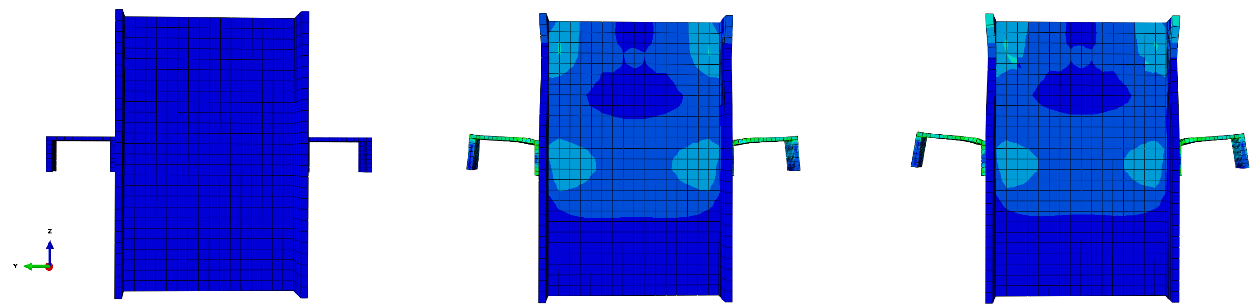
Figure 10. Step-by-step deformation of the model.